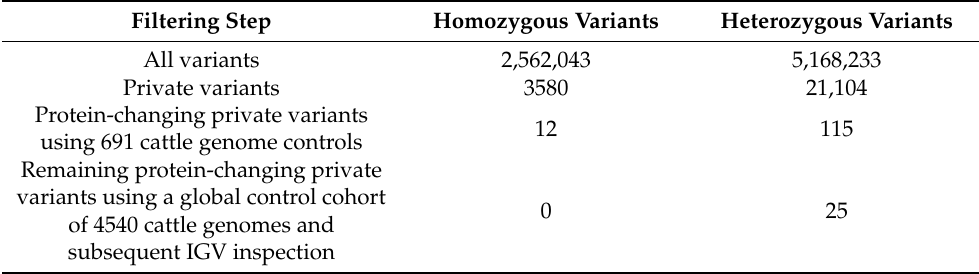
Table 2. Results of whole-genome sequencing variant filtering of the calf affected by paramyotonia congenita and